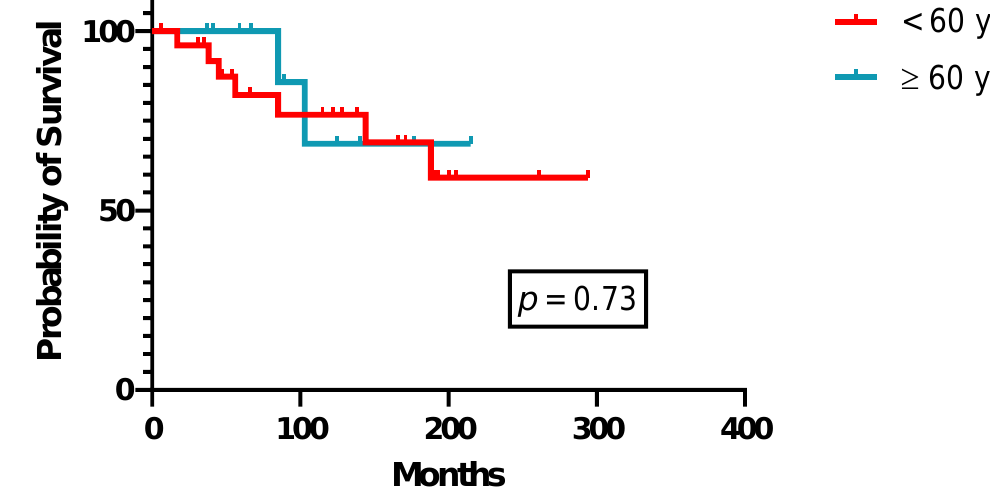
Figure 2. Progression-free survival after first-line 2-CdA according to age at diagnosis ( n = 42).